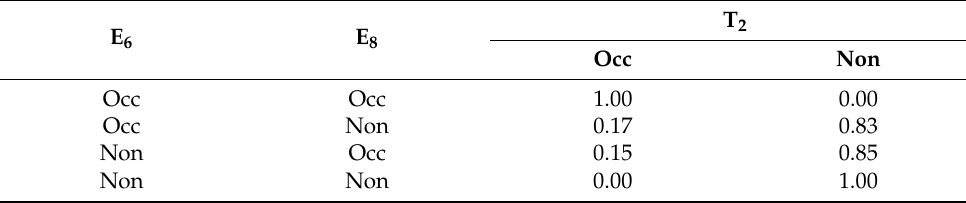
Table A10. The CPT of event T 2 (Corrosion failure; Occ: occurred; Non: non-occurred).